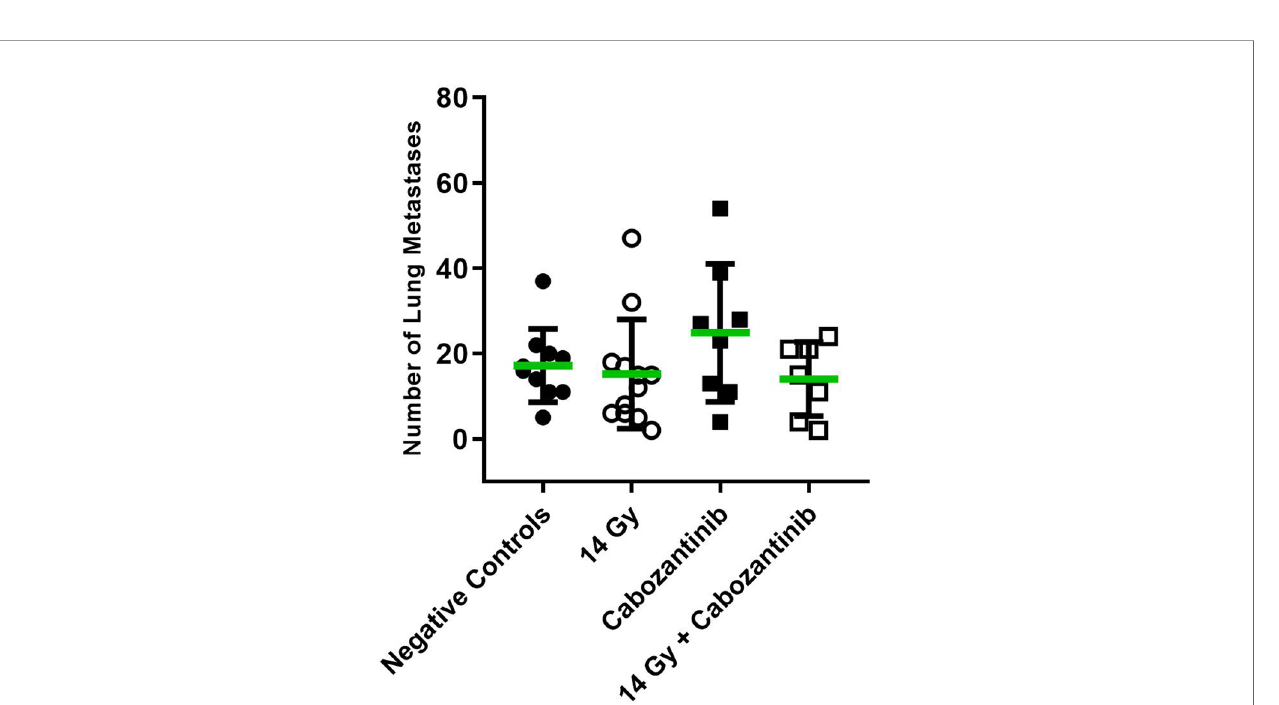
FIGURE 5 | Number of super fi cially visible lung metastases following the different treatment regimens. Mice were treated with 14 Gy, Cabozantinib or both. Upon scari fi cation on day 26 and resection, lungs were stained as described and the number of super fi cially visible metastases were counted (N=8-12). Signi fi cance was tested using a One-way ANOVA